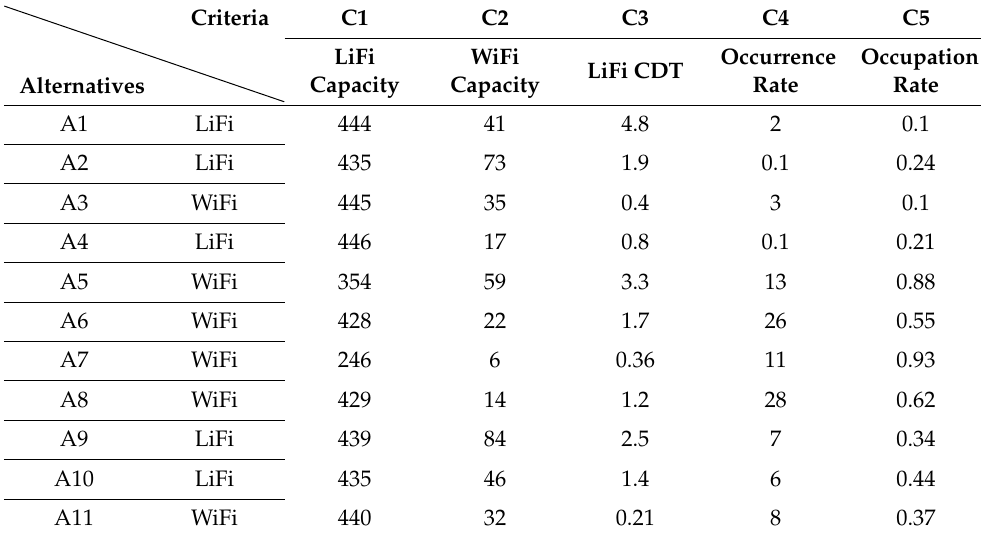
Table 7. Decision matrix for hybrid LiFi with APA possibilities.